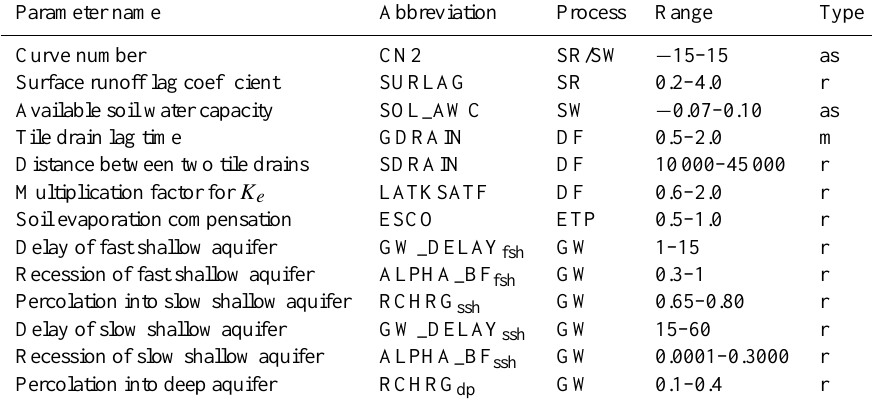
Table 2. Selection of parameters and their ranges for the temporal sensitivity analyses. The three methods to change parameter values used are replacement (r), multiplication (m), and addition/subtraction (as). The parameters are assigned to the hydrological process they control including surface runoff (SR), soil water storage (SW), drainage flow (DF), evapotranspiration (ETP), and groundwater flow